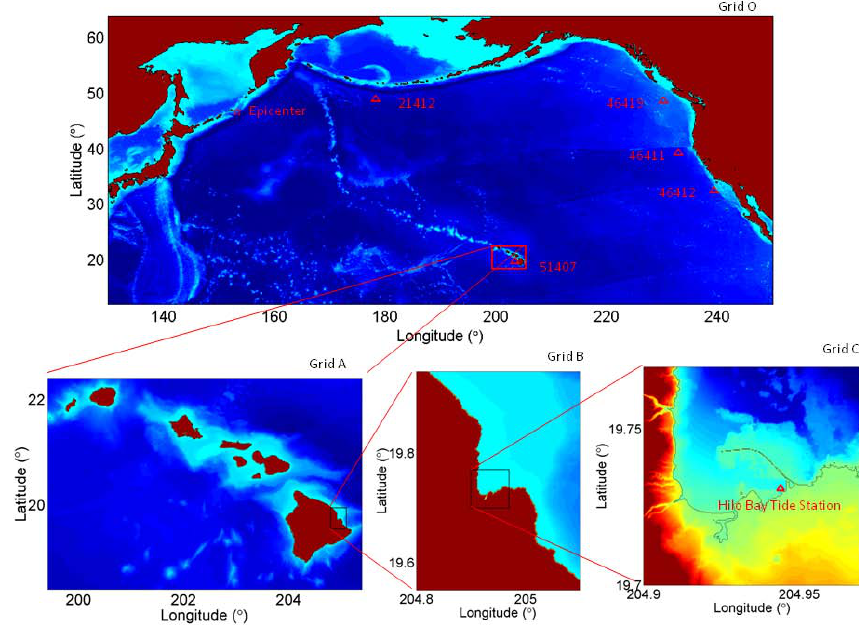
Fig. 15. Computational grids for the simulation of the 2006 Kuril Islands tsunami.